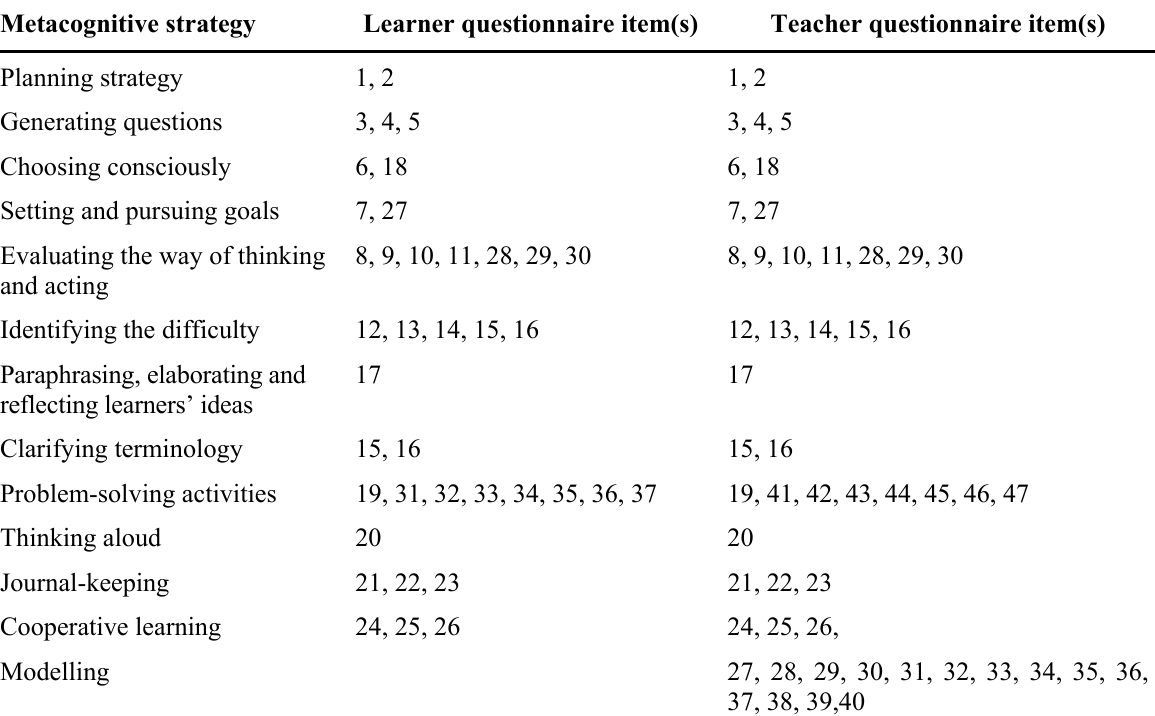
Table 1: Correspondence between questionnaire item number(s) and metacognitive strategies Metacognitive strategy